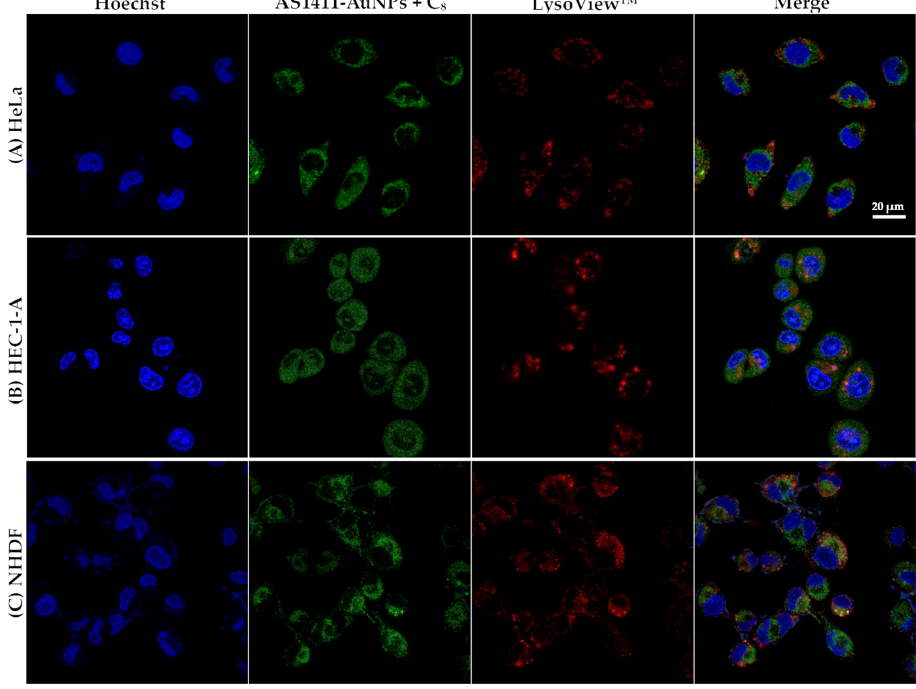
Figure 5. Confocal fluorescence images of ( A ) HeLa, ( B ) HEC-1-A, and ( C ) NHDF cell lines incubated with AS1411-gold nanoparticles with C 8 (AS1411-AuNPs + C 8 ; green) for 2 h at 37 ◦ C. Lysosomes are stained with LysoViewTM shown in red. Cell nuclei are stained with Hoechst 33342 (blue). Scale bar: 20 µ